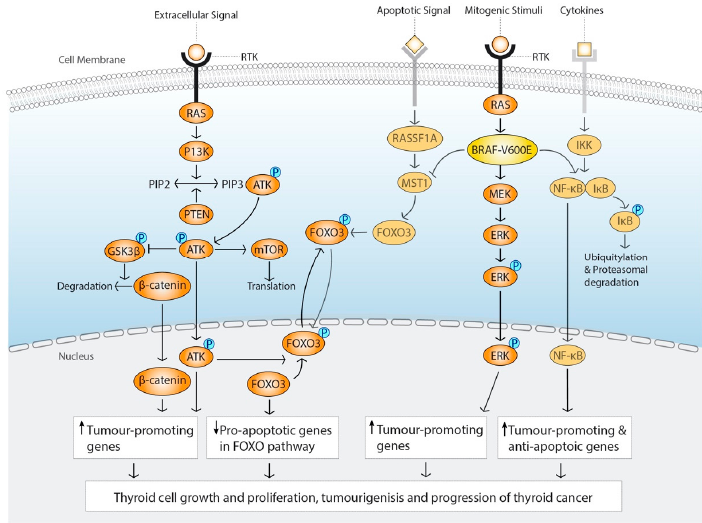
Figure 1. Molecular landscape in thyroid cancer.